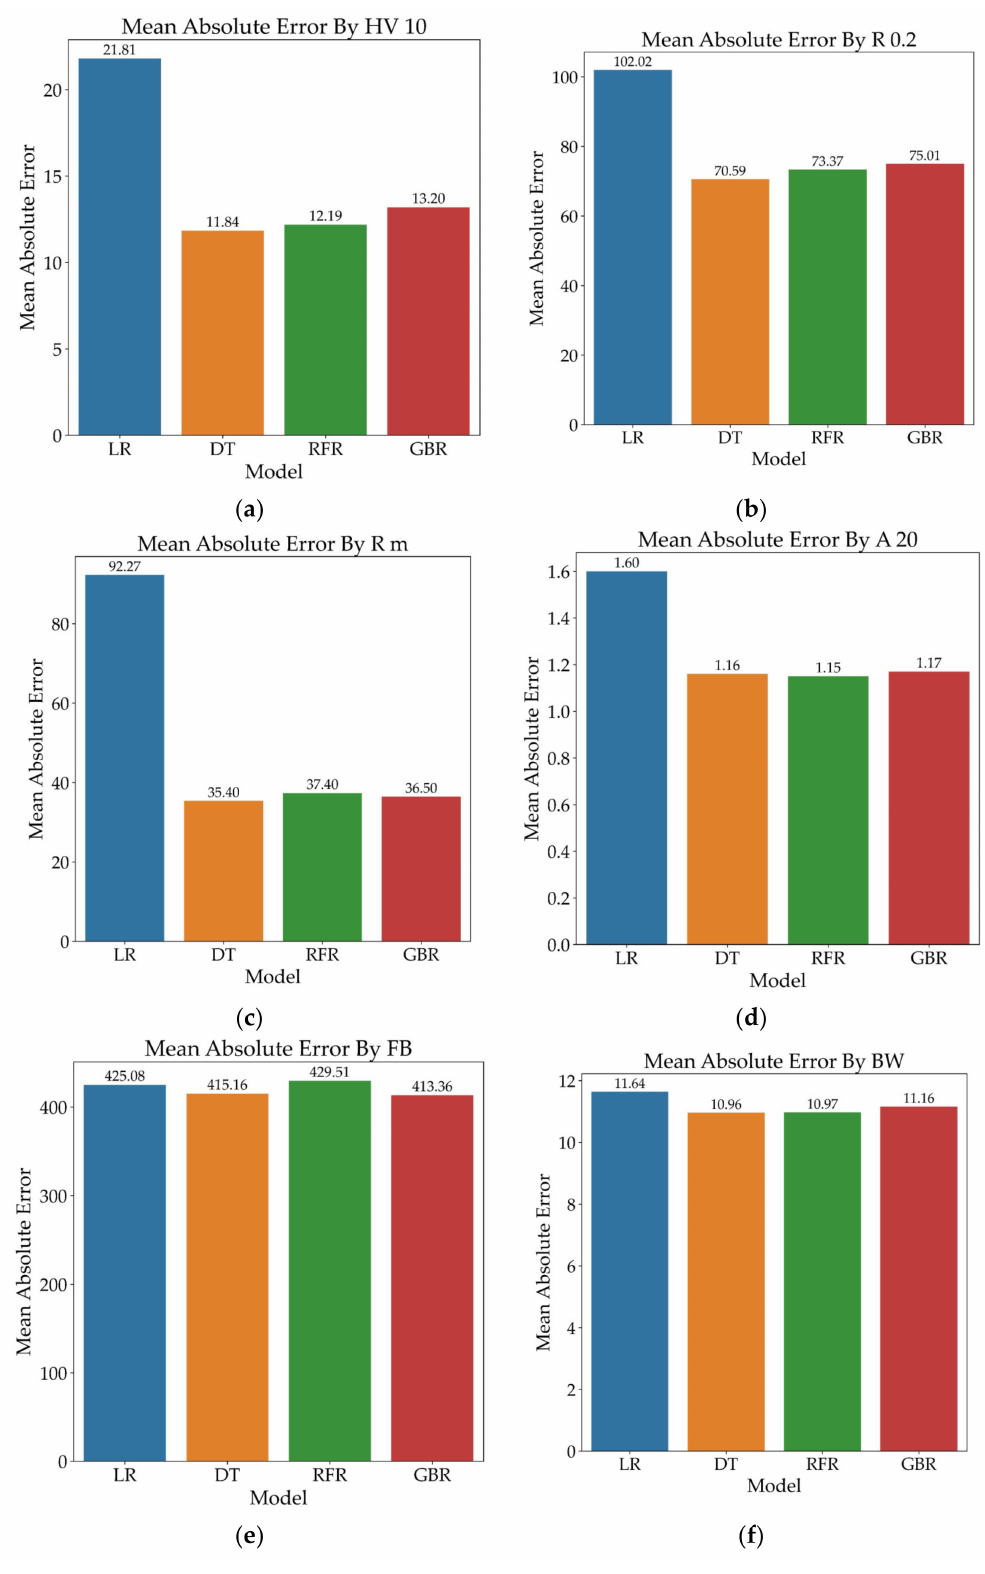
Figure 16. MAE histogram of the proposed method in modelling the alloy based on different